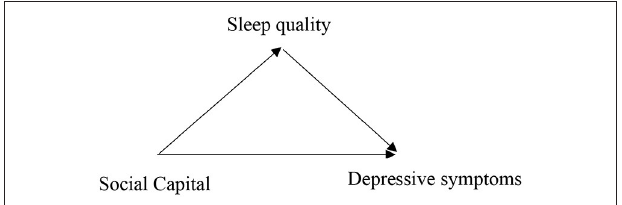
FIGURE 1 | Diagram for the mediation